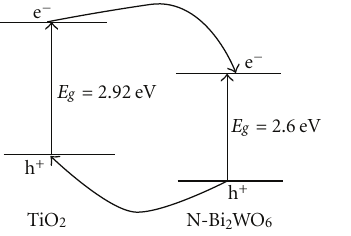
Figure 10: Schematic diagram for energy band matching and electron-hole